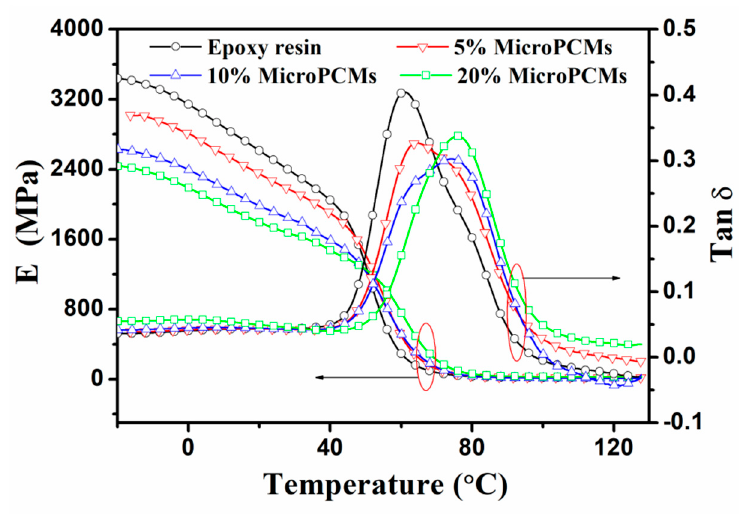
Figure 11. DMA thermograms of pure epoxy resin and MicroPCMs/epoxy composites with various MicroPCM contents.